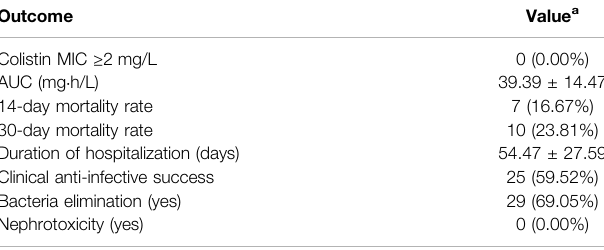
TABLE 2 | Total outcomes of patients. Outcome Value